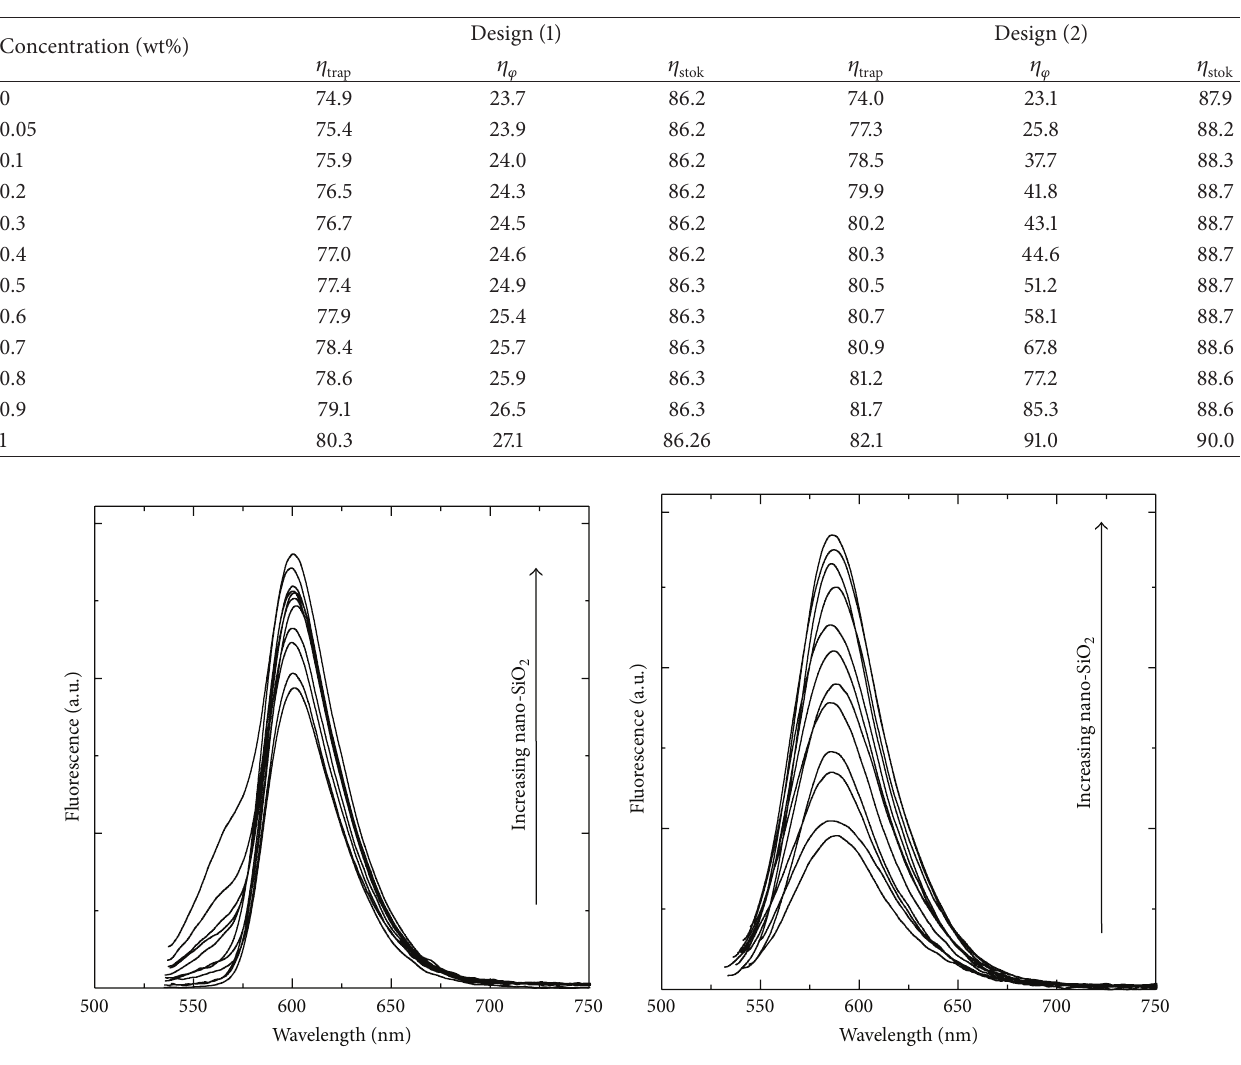
, 𝜂 𝜑 , and 𝜂 for all TLSC designs. trap stok